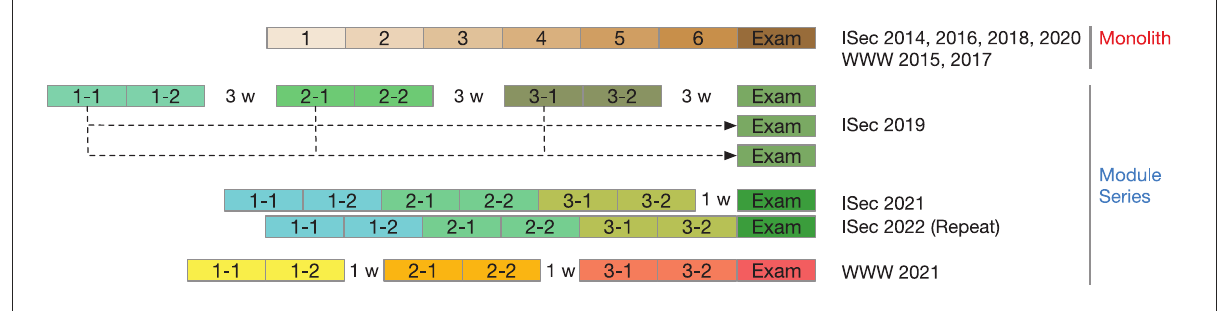
FIGURE1 Comparison of the structure of the different course types: monoliths vs. module series and a separated exam. Color-coded are the different courses with an annotation of the length of breaks between modules.